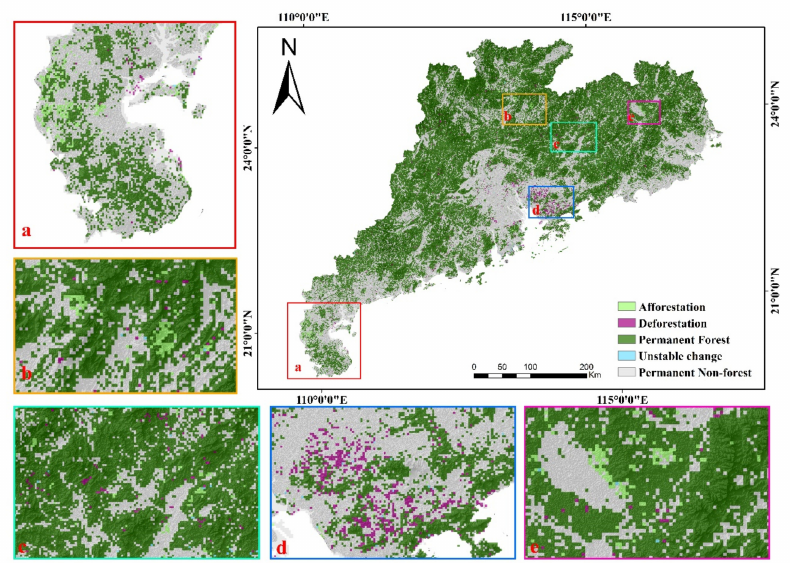
Figure 4. Five forest change trends in GHKM during 1980–2015: ( a ) obvious afforestation in Leizhou Peninsula; ( b ) obvious afforestation in NGR; ( c ) obvious artificial forest management and changes in NGR; ( d ) obvious deforestation in Shenzhen and Dongguan (GHKM–GBA); ( e ) obvious afforestation in EGR.